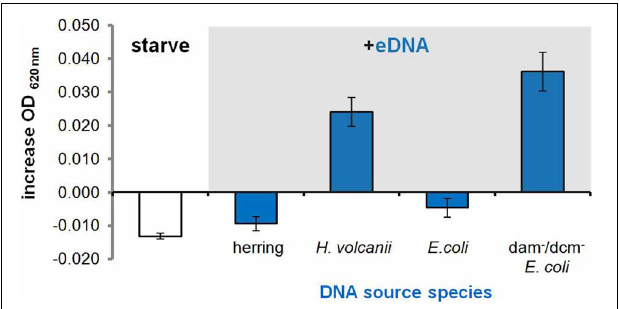
FIGURE 4 | Selective metabolism of available eDNAs. Average increase in OD of P-starved H. volcanii cultures in CN medium 16 hours after supplementation with 250 μ g/ml eDNA isolated from different source species. Error bars are standard deviation of replicates.